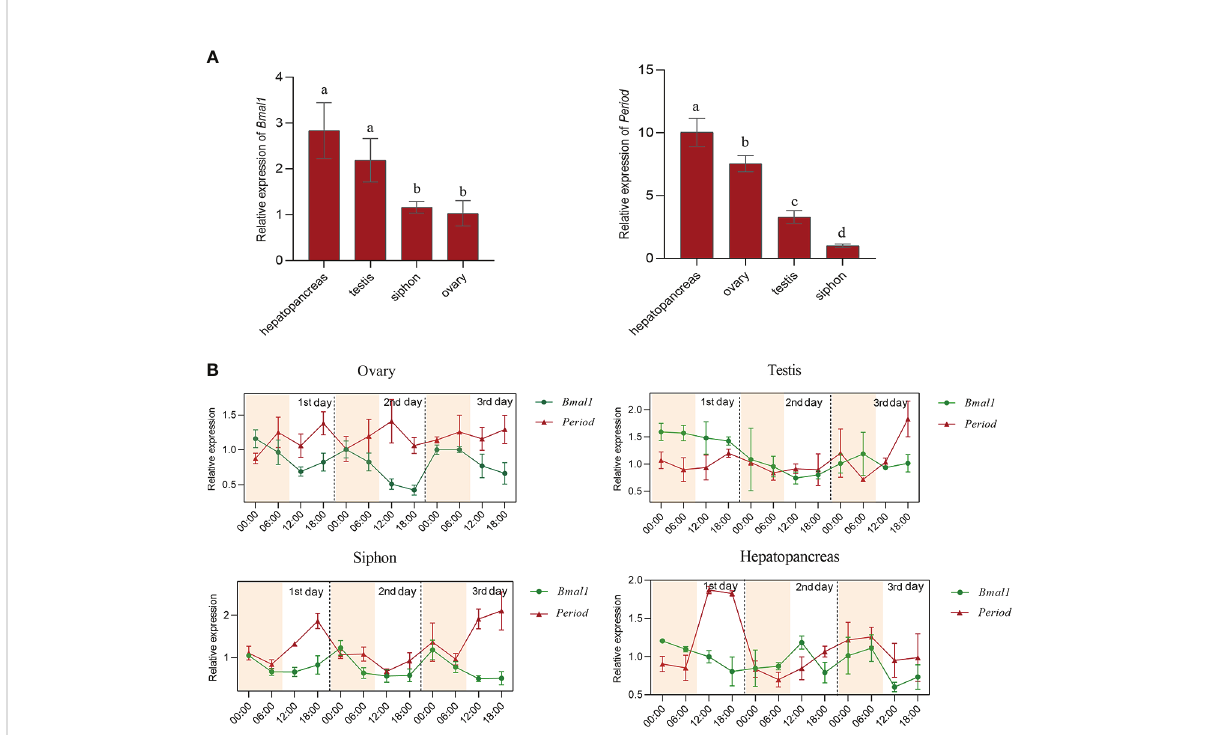
FIGURE 3 Expression pattern analysis of Bmal1 and Period in S. constricta . (A) The relative mRNA expression of Bmal1 and Period in four tissues (n=6).